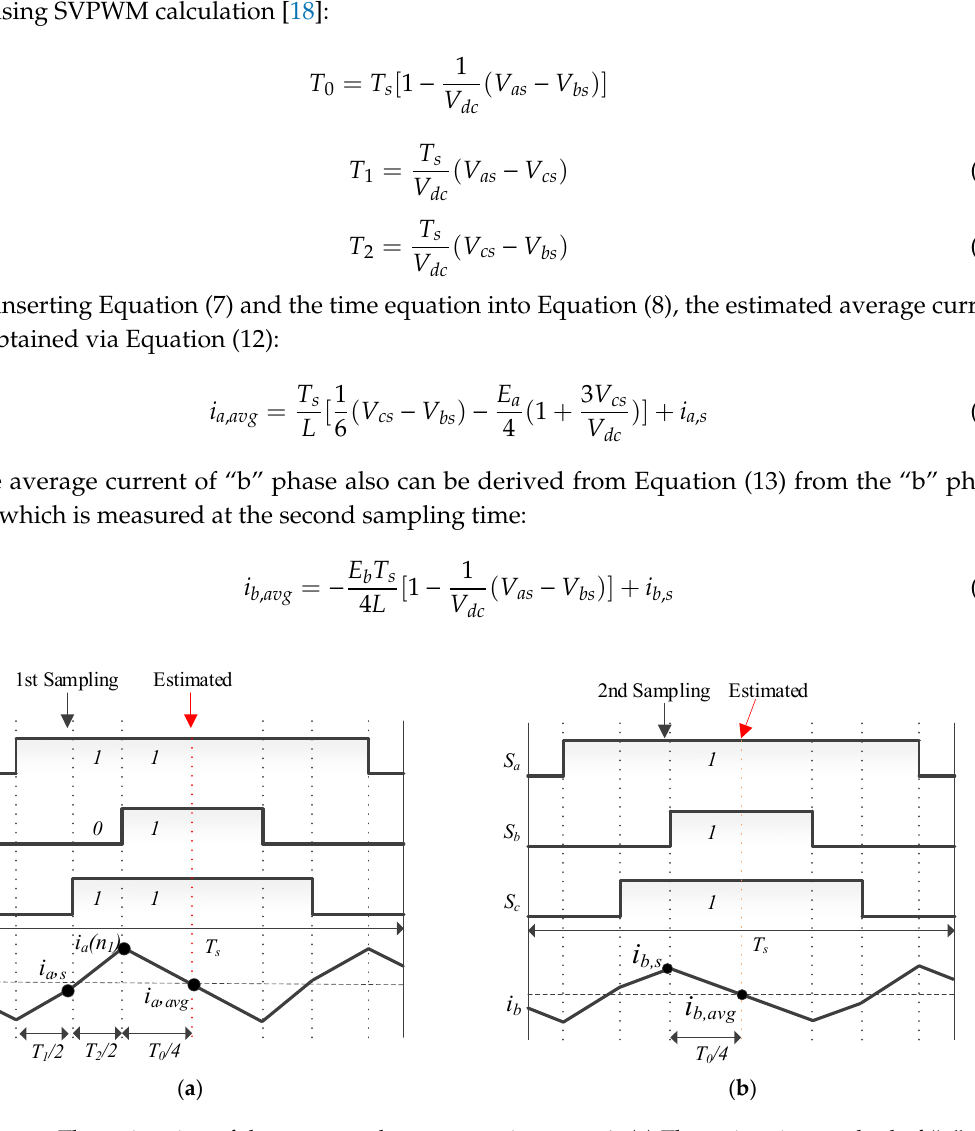
Figure 6. The estimation of the average phase current in sector 6: ( a ) The estimation method of “a” phase current at the 1st sampling time; ( b ) the estimation method of “b” phase current at the 2nd sampling time.